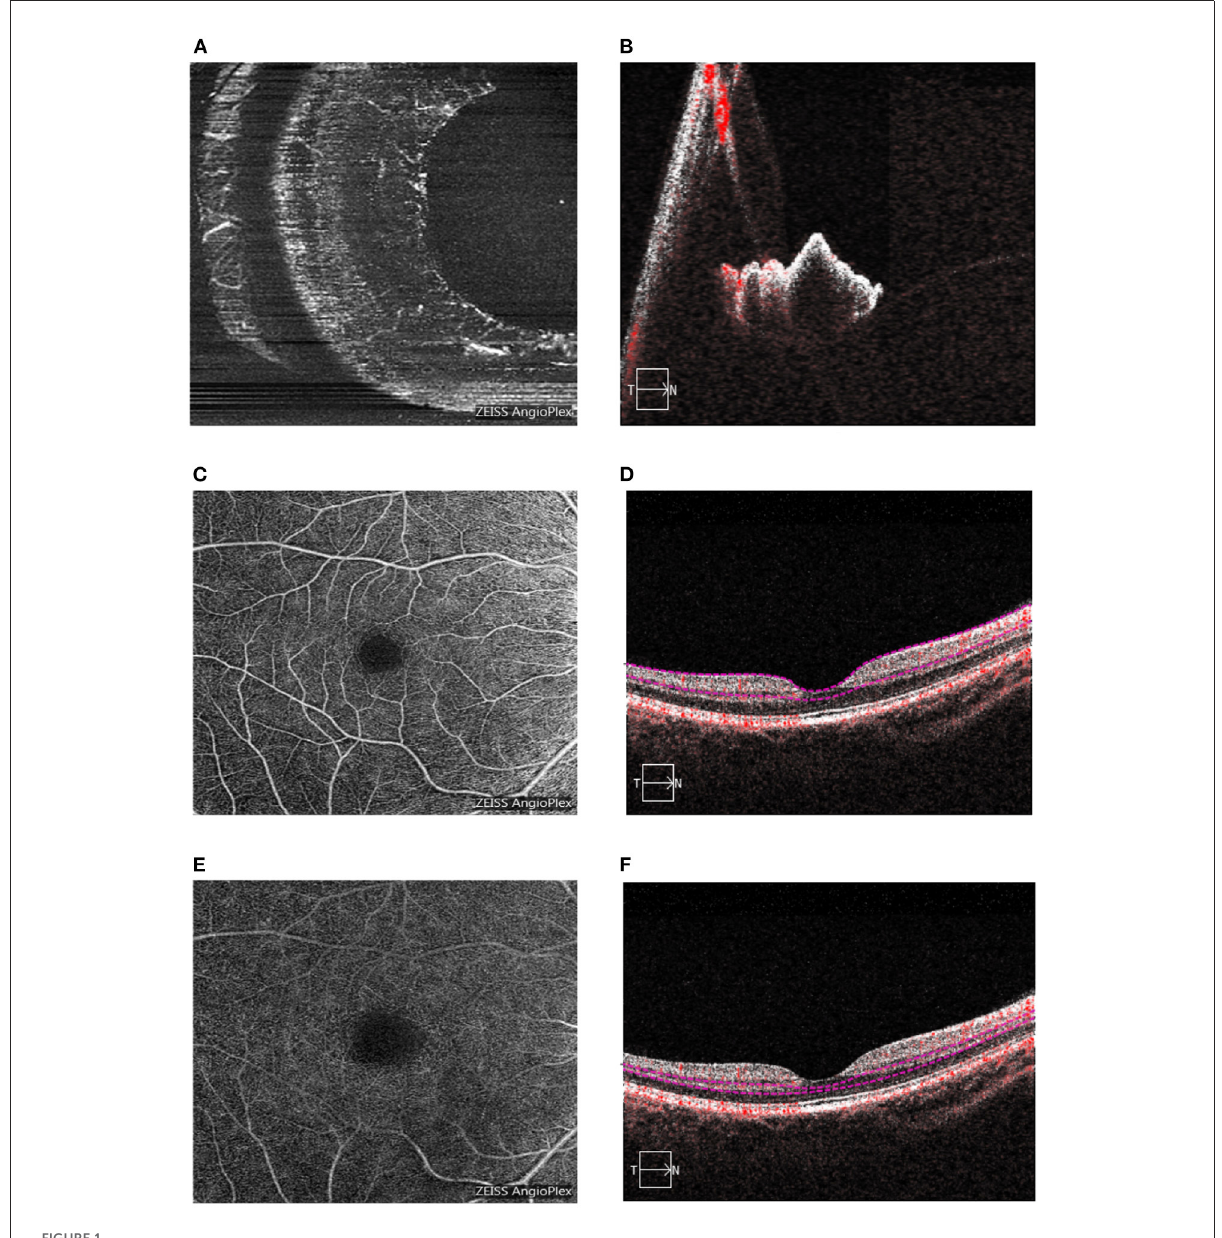
FIGURE1 The iris and retina OCTA